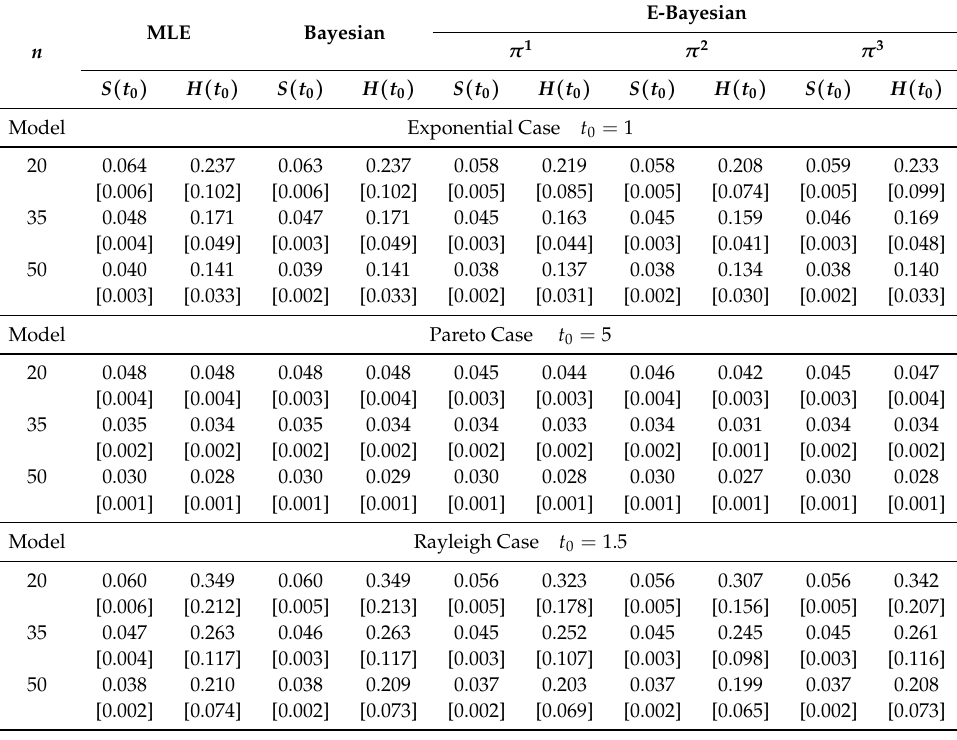
Table 8. The AB and MSEs (within bracket) of point estimates with ( c 1 , c 2 , c 3 ) = ( 3,2.5,2 )